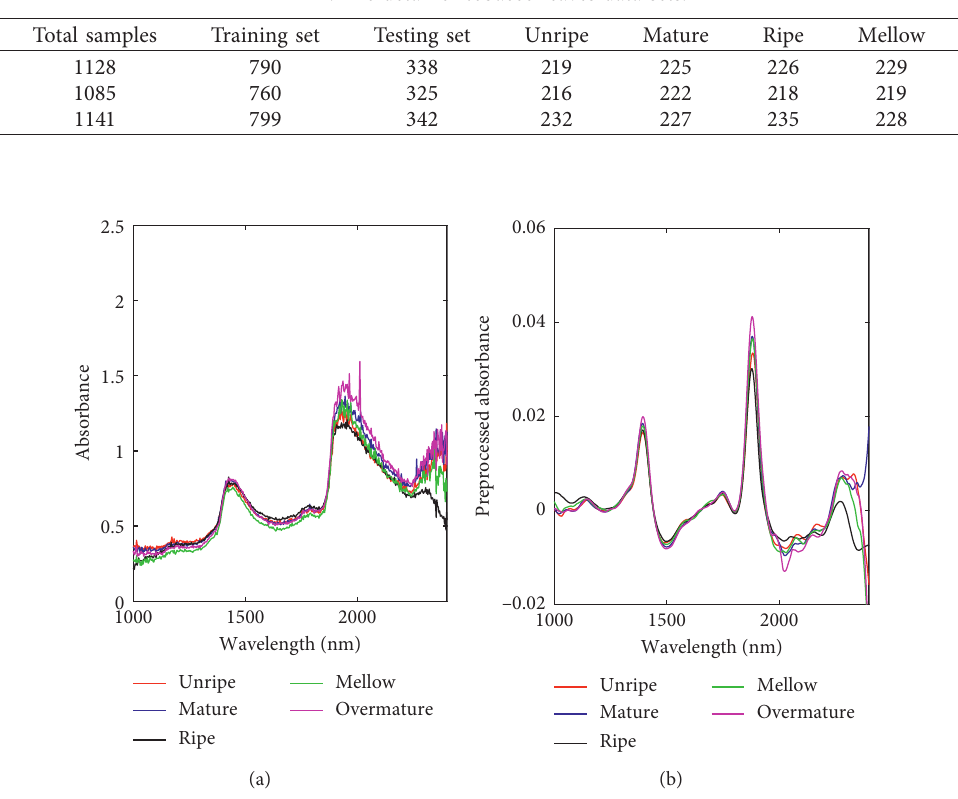
Figure 1: The NIR spectra of five maturity levels of upper tobacco leaves: (a) raw spectra and (b) preprocessed